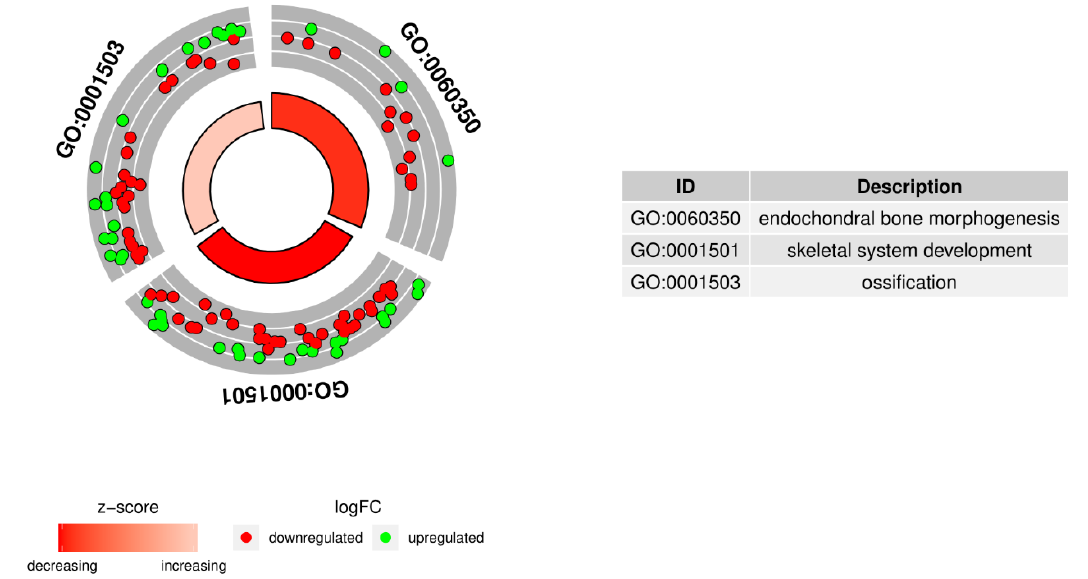
Figure 2. The circular visualization of the results of gene annotation enrichment analysis. The outer circle shows a scatter plot for each term of the logFC of the assigned genes. Green circles display upregulation, and red ones display downregulation. The inner circle is the representation of Z-score. The size and the color of the bar correspond to the value of the Z-score.